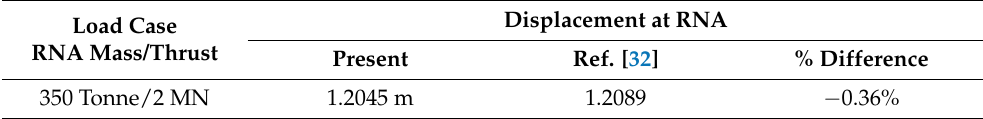
Table 6. Static deformation of the baseline wind turbine